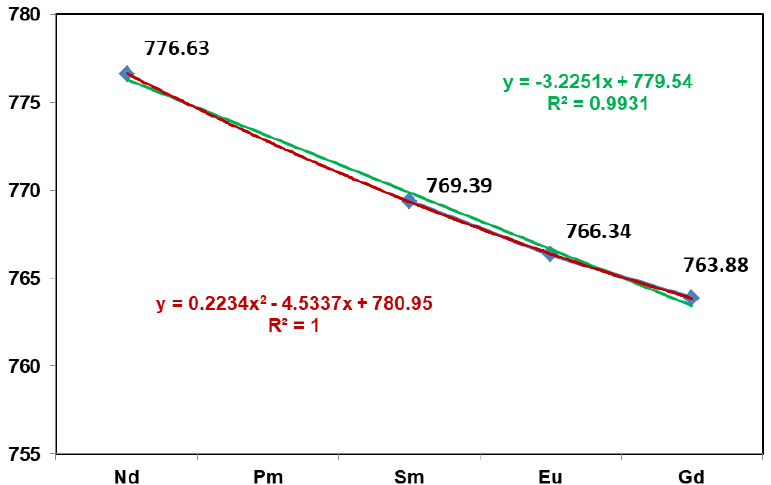
Figure 4. Evolution of the unit cell volumes [Å 3 ] in compounds of the RE(OAc) 3 · 2AcOH structure type as a function of the RE atomic number. Trend lines of linear regression analysis and formula are given in green, those of the quadratic regression analysis in red.